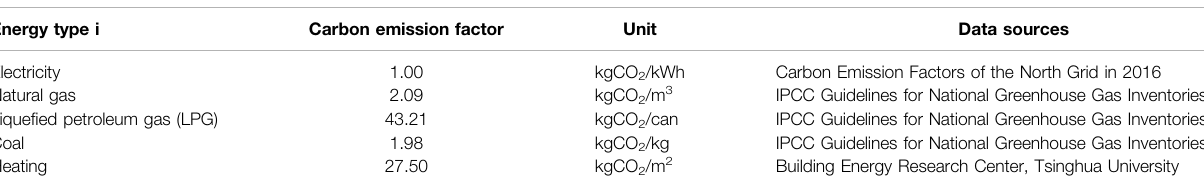
TABLE 1 | Carbon emission factor of